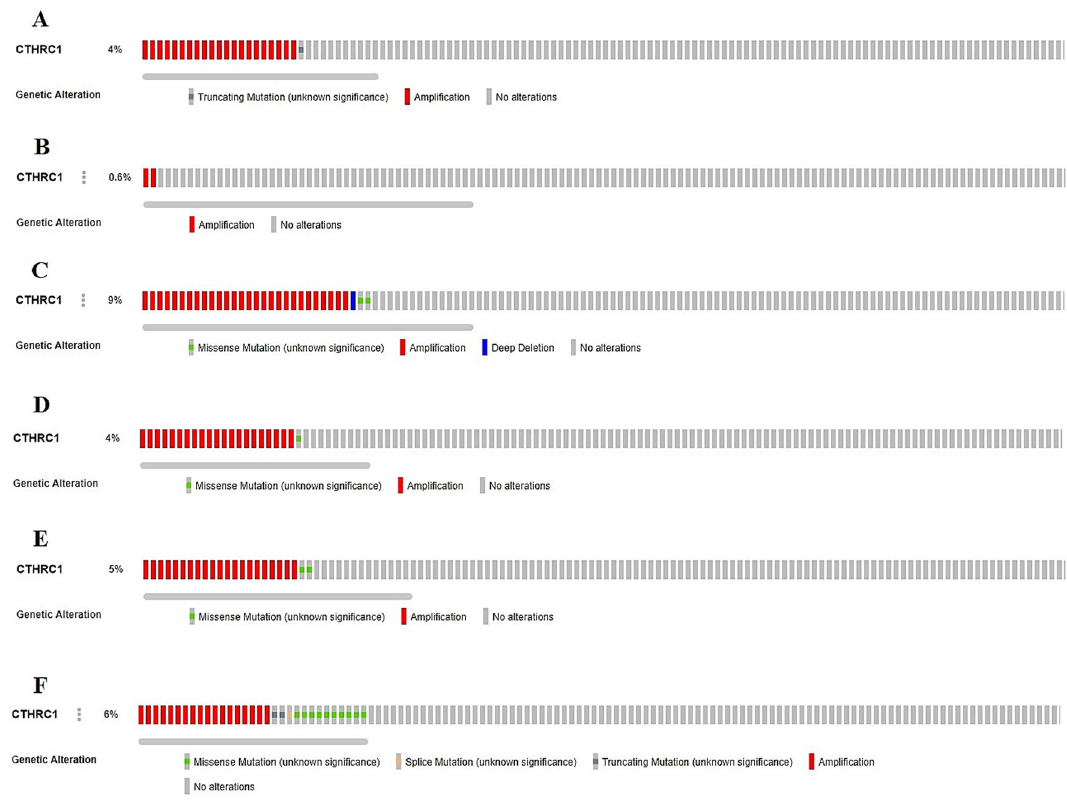
Figure 13. CTHRC1 genetic alterations and copy number variations (CNVs) in TCGA HNSC, KIRC, LIHC, LUAD, STAD, and UCEC datasets. ( A ) HNSC, ( B ) KIRC, ( C ) LIHC, ( D ) LUAD, ( E ) STAD, and, ( F ) UCEC.